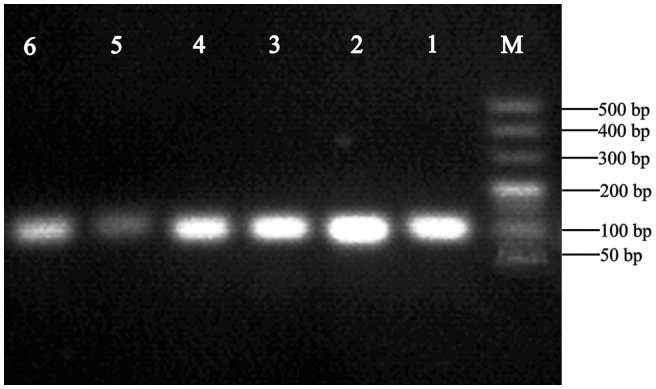
Analysis of amplicons by agarose electrophoresis.M, DNA maker DL500 (Takara); 1, rs10514919; 2, rs5919; 3, rs5918; 4, rs3859865; 5, rs2317676; 6, rs2015729.